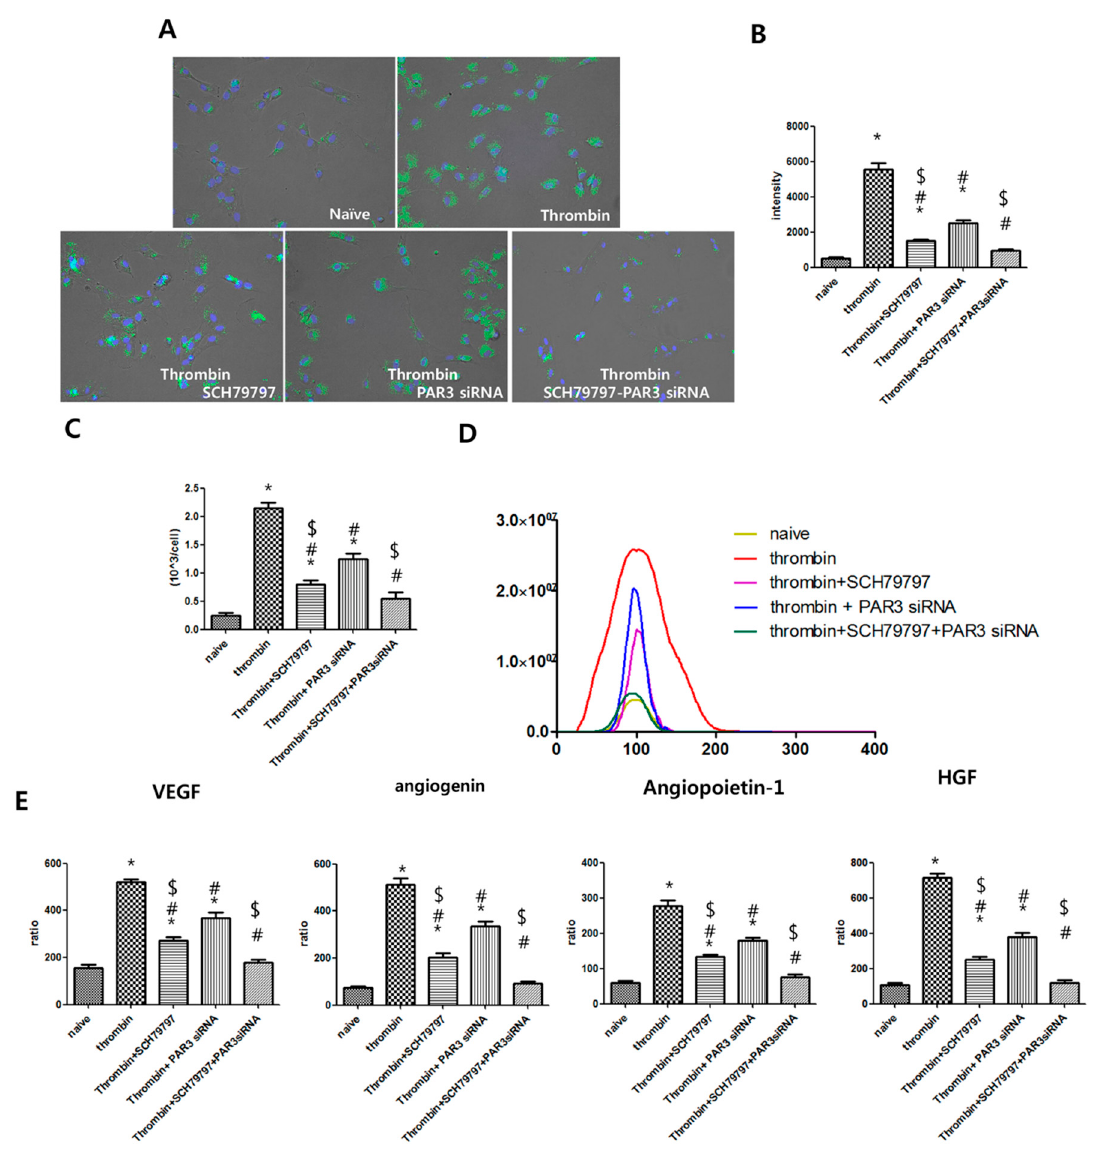
Figure 4. Protease-activated receptors, PAR1 and PAR3, are involved in endosome production by umbilical cord-derived mesenchymal stem cells and protein cargo contents in extracellular vesicles after thrombin preconditioning. ( A ) After thrombin preconditioning of umbilical cord-derived mesenchymal stem cells (UCB-MSCs), the number of endosomes was determined by labeling early endosomes with green fluorescent protein(GFP-green) and the nuclei with 4',6-Diamidino-2-Phenylindole, Dihydrochloride (DAPI-blue). ( B ) Bar graph showing the quantified intensities of the endosome-GFP signal. ( C ) After treatment with thrombin and thrombin inhibitor, the number of extracellular vesicles (EVs) was determined using a NanoSightNS300. ( D ) The size and number distribution of EVs as measured and analyzed by Nanoparticle Tracking Analysis software. ( E ) After treatment with thrombin and thrombin inhibitor, the levels of VEGF, angiogenin, angiopoietin, and HGF in the EVs were measured by multiplex ELISA. Following treatment with thrombin and thrombin inhibition, EVs were isolated from the conditioned media of UCB-MSC cultures, and VEGF, angiogenin, angiopoietin, and HGF protein levels were assessed. An asterisk (*) indicates a significant difference vs. naive EVs, a number sign (#) indicates a significant difference vs. thrombin-treated UCB-MSC and a dollar sign ($) indicates a significant di ff erence vs. thrombin + PAR3 siRNA UCB-MSC ( p < 0.05, two-sample t -test; n = 6 per